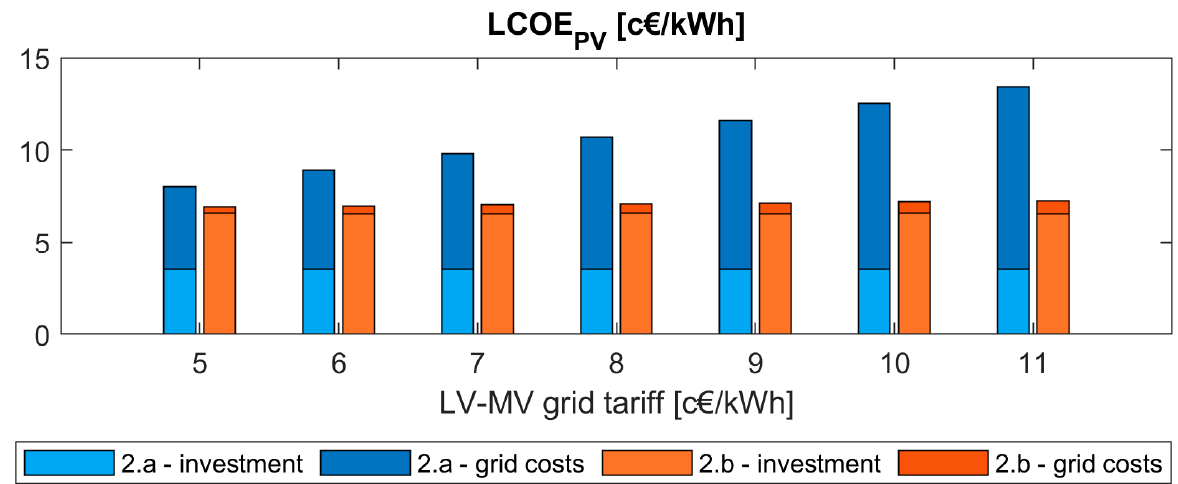
Figure 12. Comparing scenarios 2a (in blue) and 2b (in orange) regarding the LCOE PV . This cost was decomposed in technology investment (in light color) and grid costs (in